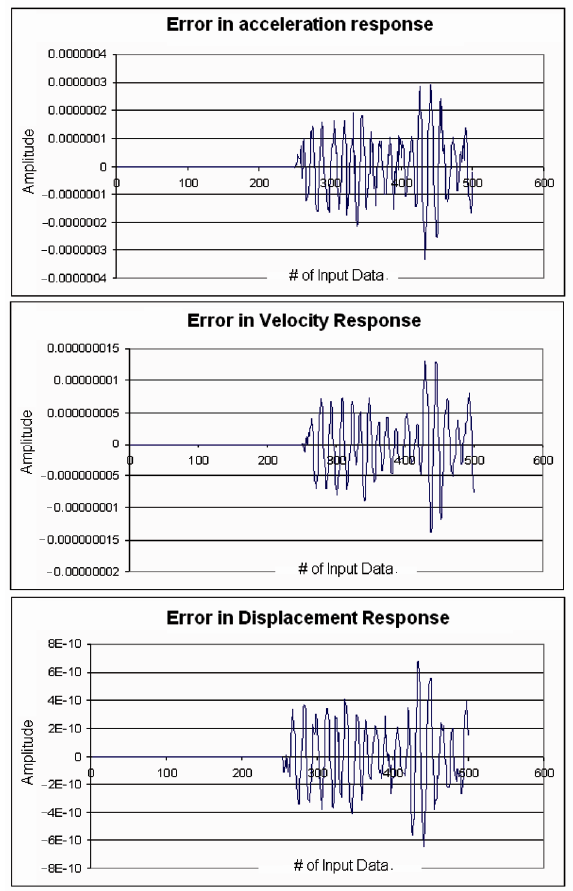
Fig. 9. Difference of results from Parallel Program & Sequential Program